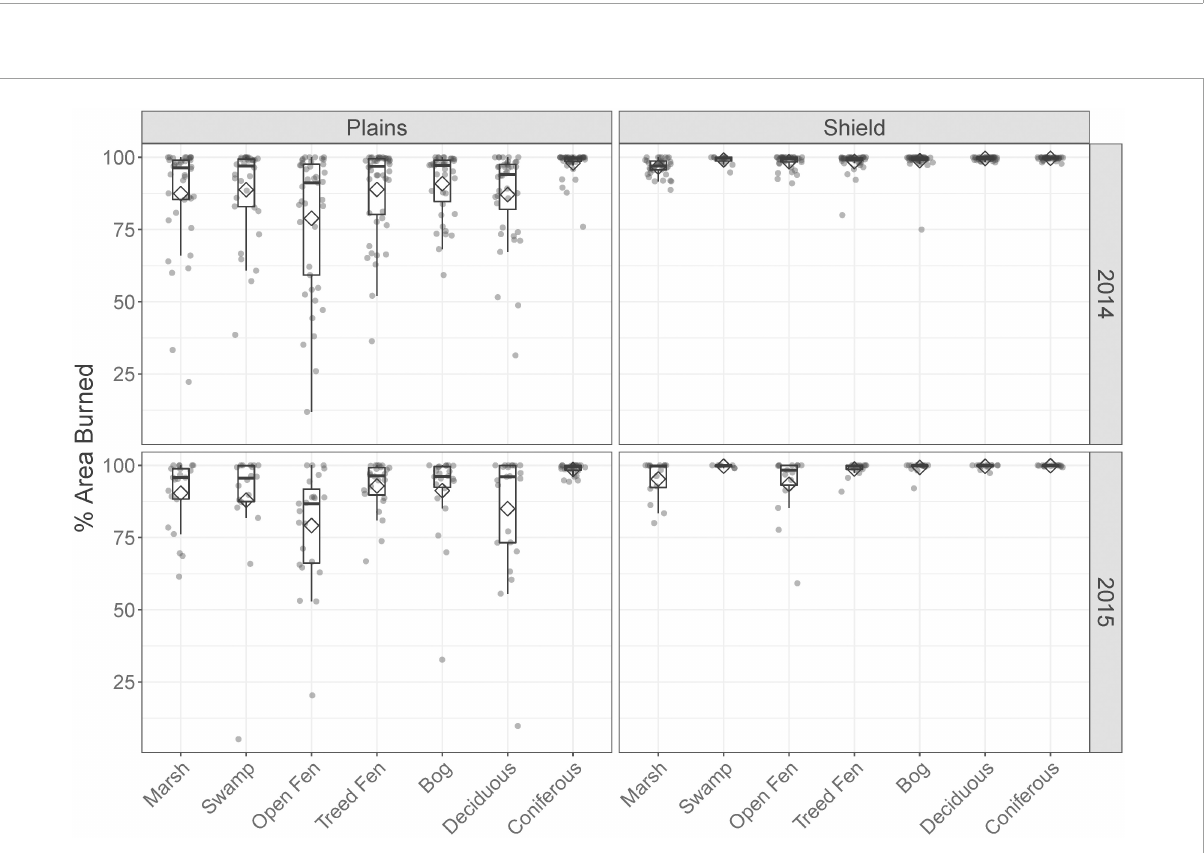
FIGURE6 Box plots, separated by ecoregion and year, showing the mean percent area burned of each ecotype as diamond and actual data values plotted as gray circles.